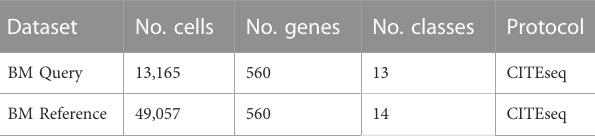
TABLE 2 Description of bone marrow datasets included in this study.